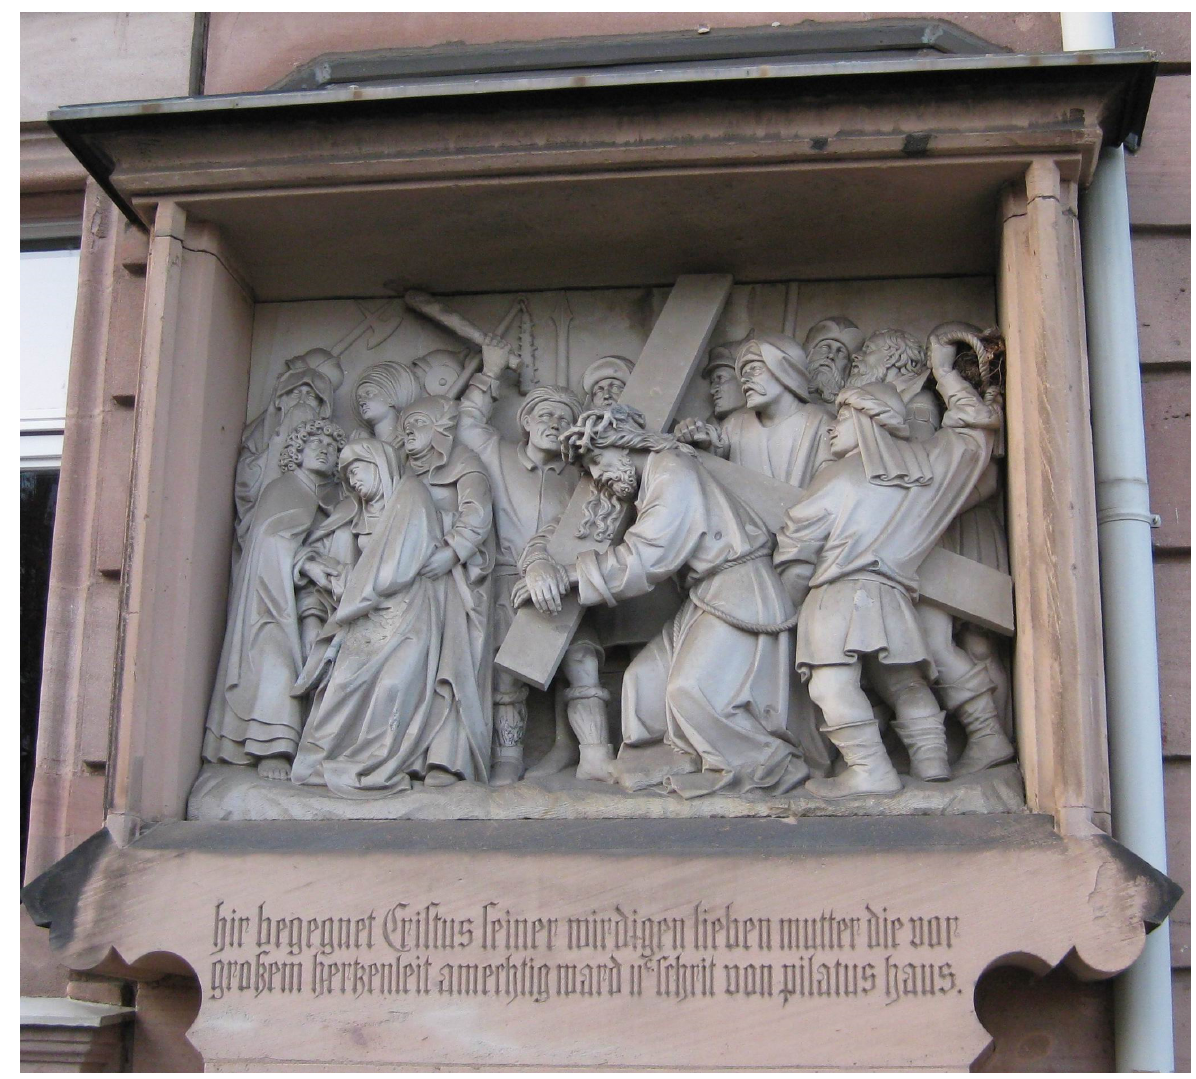
Figure 15. Kraft, Stations of the Cross, Nuremberg, 1506–1508. Station One (reconstruction). Kraft’s second relief (Figure 16) shows the familiar episode when Simon of Cyrene is drafted to share the burden of the cross (Matthew 27: 32; Mark 15: 22; Luke 23: 26). Several of the same ugly heads reappear here among the tormentors, who are now three deep. They completely surround the cross and Jesus, who is now positioned slightly left of center. The overall movement still remains right-to-left, as Christ’s knees still buckle, despite his added assistance with his burden. Two men press Simon onto the diagonal cross, while a man in armor between Simon and Jesus tugs at his hair to add further torment and delay. At the front of the procession, a backward-facing man, seemingly tugging at Jesus with a rope, bends backward and almost breaks out of the left frame. The inscription reads: ‘Here Simon is compelled to help Christ carry his cross. 295 steps from the House of Pilate.